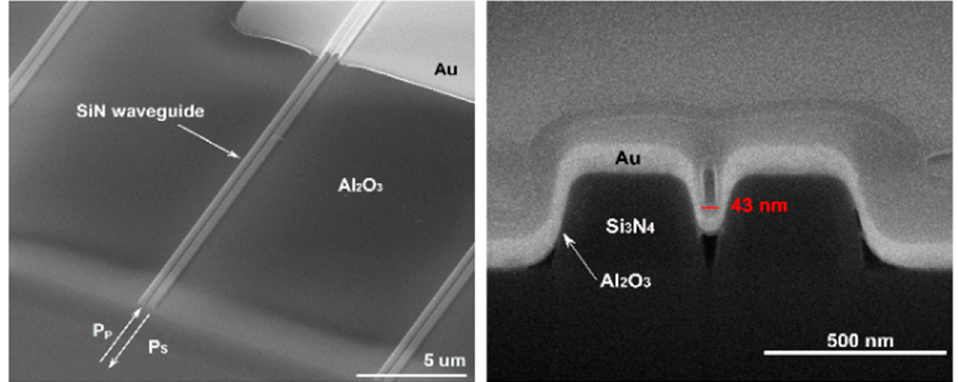
Figure 7. (Reprinted with permission from [61] © Optica) Waveguide-based nanoplasmonic slot waveguide top view and cross-section.